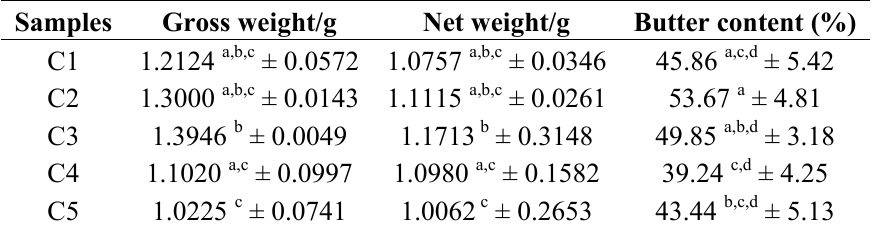
Table 1. The average weight and butter content of a cocoa